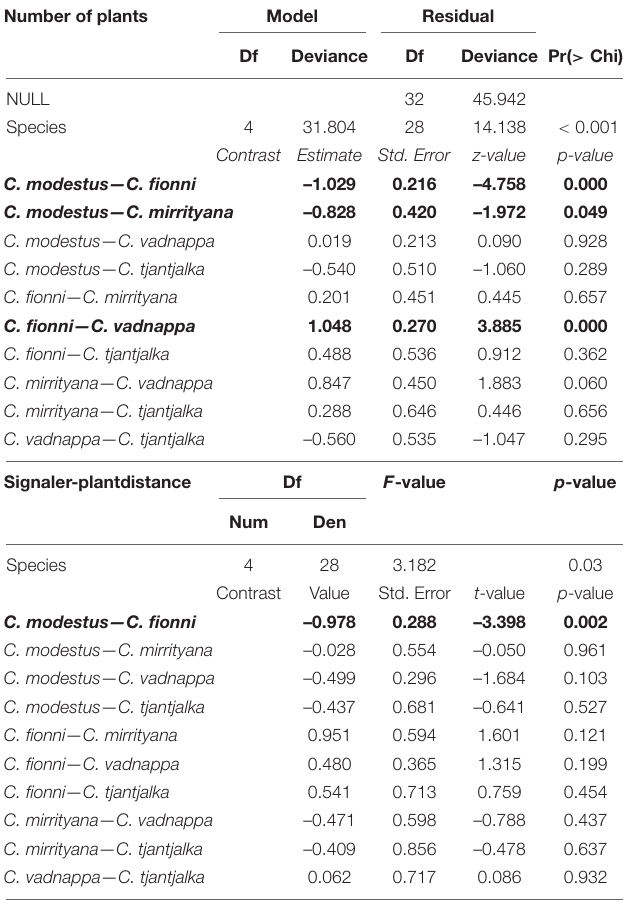
TABLE 4 | Outcome of statistical models for plant number and s-p distances, using a generalized linear model and a linear mixed model, respectively, to compare microhabitat structure for each